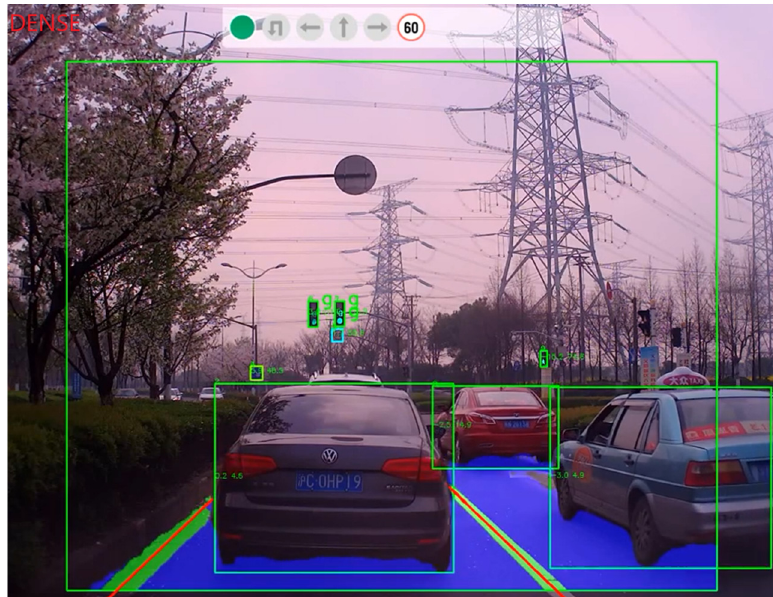
Figure 14. RTDE example output 3—DENSE scenario.